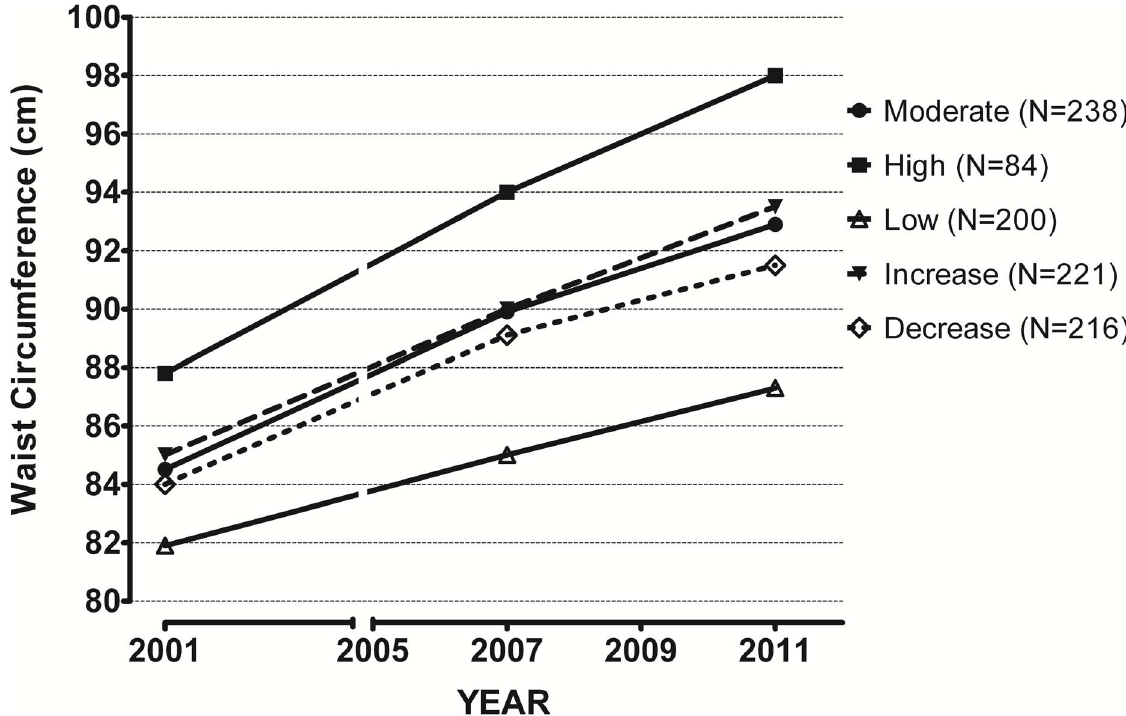
Figure 2. Waist circumference change during 10 years of follow-up depending on daily TV time, and its stability or change.